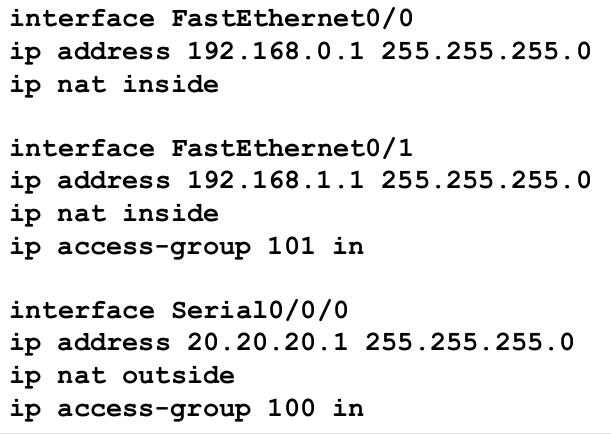
Figure 2. IP address allocation for the three